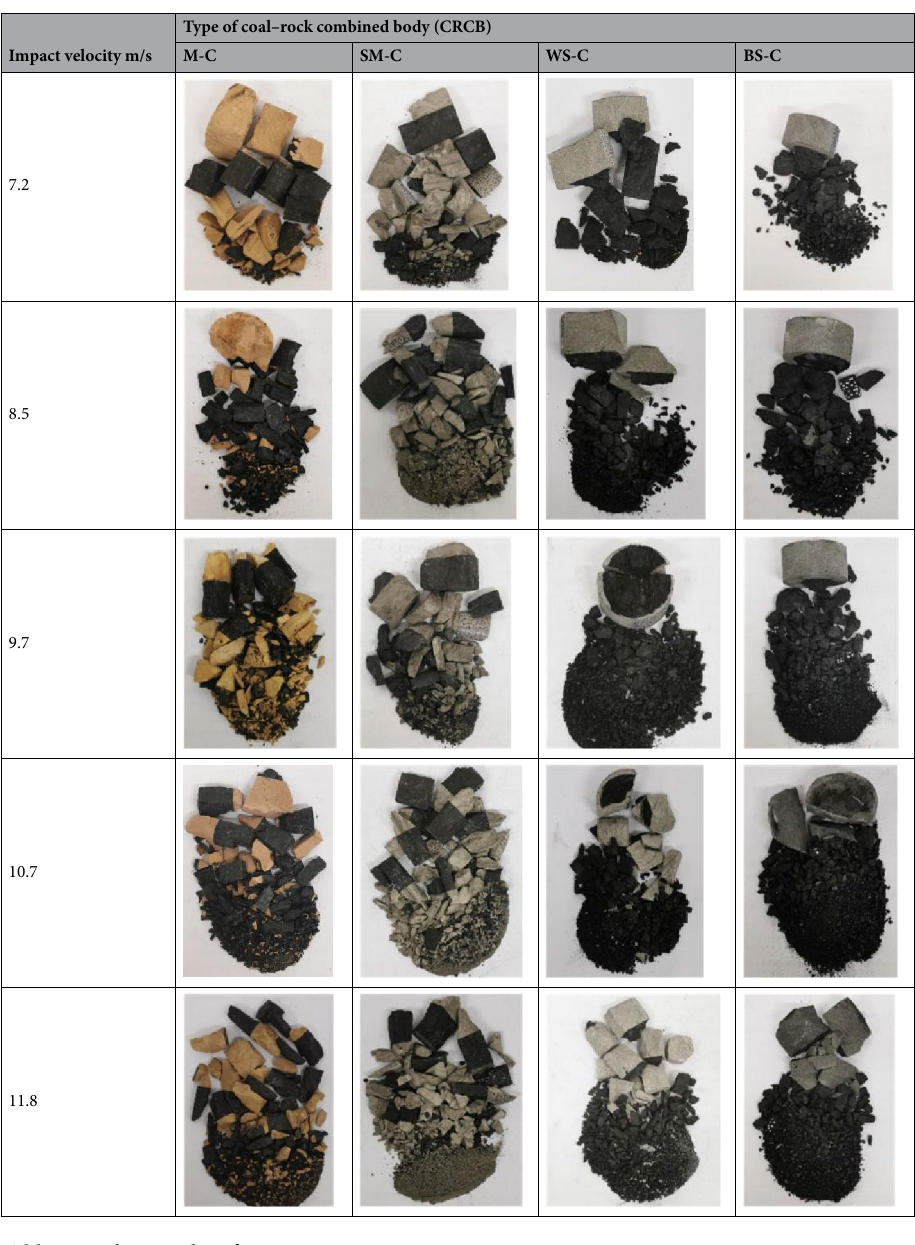
Table 4. Failure modes of CRCB